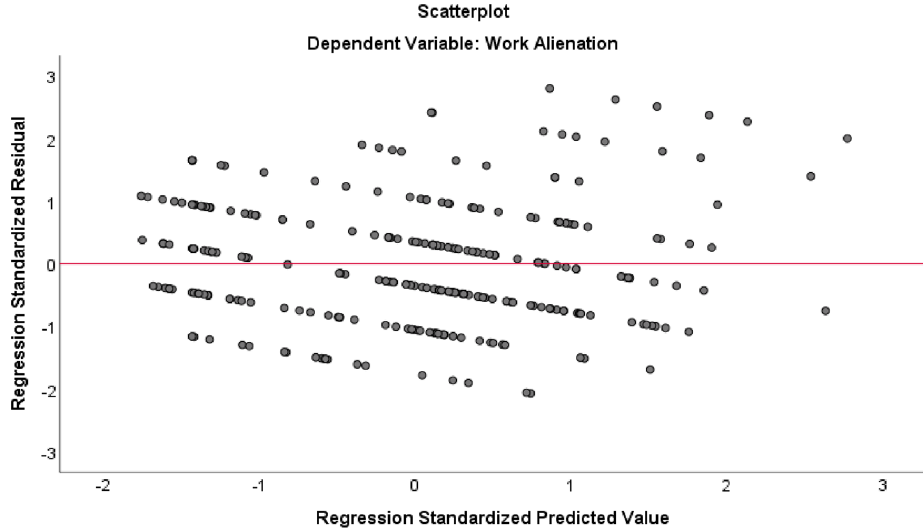
Figure 2. Regression standardized predicted value and residual scatter